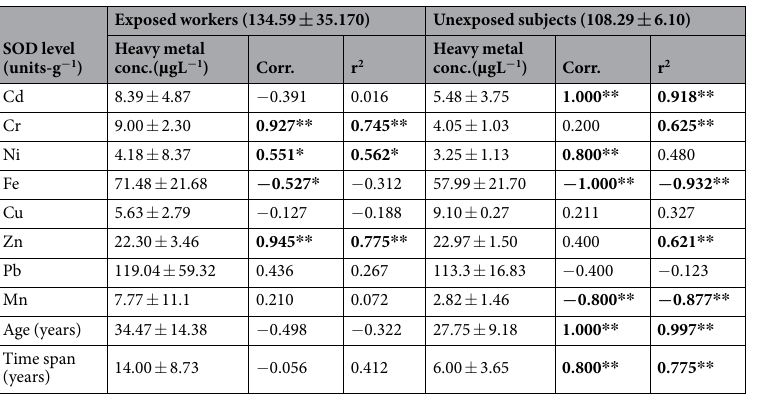
industries were lower than the RfD. In the same leather industry (T3), the highest mean HQs for Cd and Fe were calculated as 7.68 and 5.02 and the ADIs were 0.008 and 0.077 mg/kg-d, respectively. Compared to RfDs, the ADIs for both of the metals were almost 7-8 fold higher. Pb revealed the highest mean HQ of 3.28 with an estimated ADI of 0.049 mg/kg-d, which was about 300 folds higher than that of Pb’s RfD (0.00014 mg/kg-d). The mean HQs for Zn, Mn, and Cu were 0.87, 3.29, and 4.96, and their ADIs were 0.26, 0.46, and 0.20 mg/kg-d, which were 2, 4, and 5 fold higher than the corresponding RfDs (Table S9). The mean HQ value of Cr(VI) was about 134.50 with the ADI value of 0.67 mg/kg-d, which was about 120 fold higher than that of the RfD for Cr(VI). Cancer risk of Cr and Cd. The cancer risks of Cd and Cr in the exposed workers were calculated using the specifically devised cancer slope factor (CSF) values. The CSF values used in the current study are present in the Table S9. Cr expressed elevated cancer risks for the exposed workers compared to that of Cd (0.300 vs. 0.041), albeit Cd showed elevated risk than that of Cr (6.87 vs. 0.11) for non-cancer risk. Heavy metals induce oxidative stress in the exposed workers. The SOD level in the exposed group was significantly higher ( p < 0.01) than that in the control group (Table 1). Correlation analysis indicated signif- icant positive association ( p ≤ 0.01) among SOD levels and concentrations Cd, Cr and Zn in the blood with the following order: Cr > Zn > Cd for most of the exposed workers. However, no significant association revealed between SOD concentration, age, and exposure duration for the workers, albeit control subjects implied signifi- cant positive correlation for these independent variables ( p < 0.01). Moreover, adjusting the marital status, work- ing time span, and smoking, the linear regression coefficients showed that SOD levels in blood were significantly dependent on Cr (r = 0.74), Cd (r = 0.92), and Zn (r = 0.88).